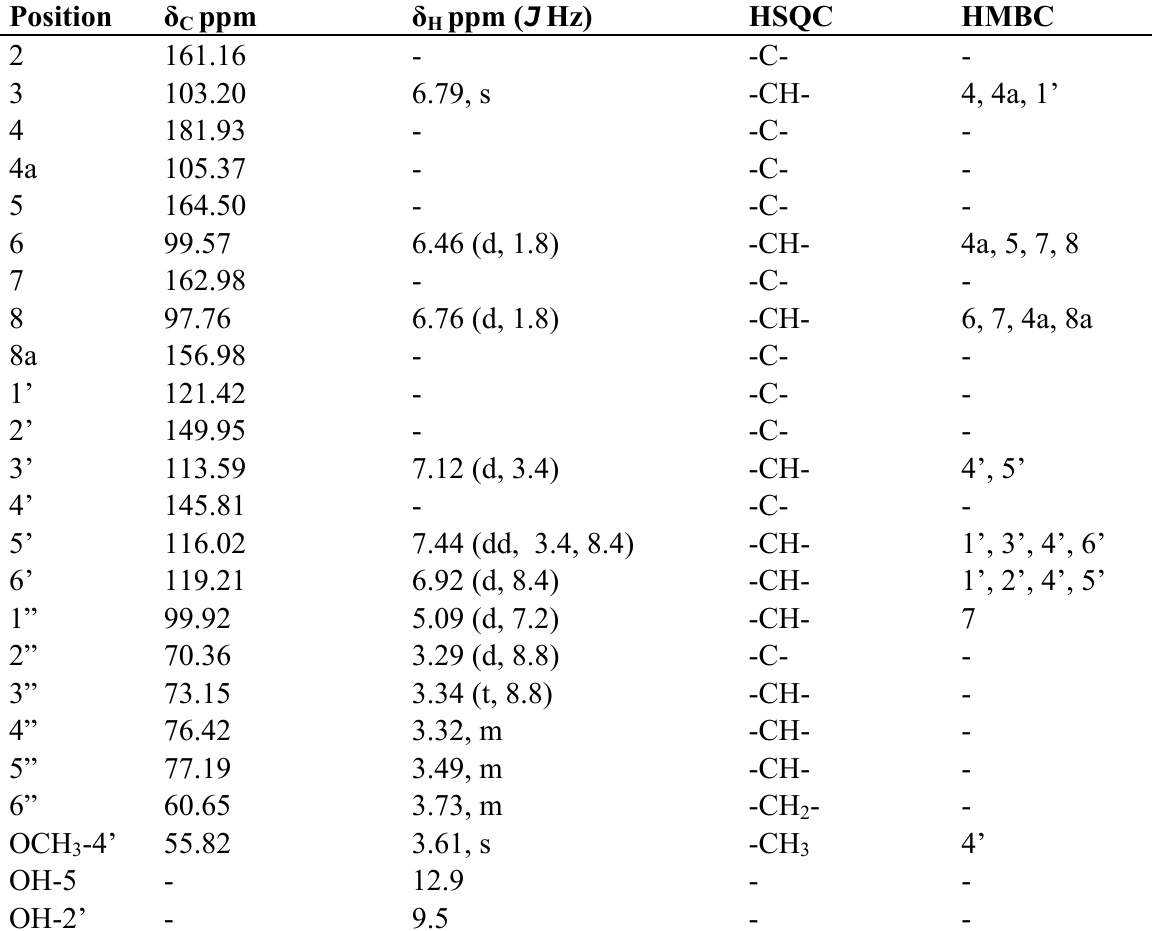
Table 1. 13 C, 1 H-NMR, HSQC and HMBC data of compound 1 in CDCl